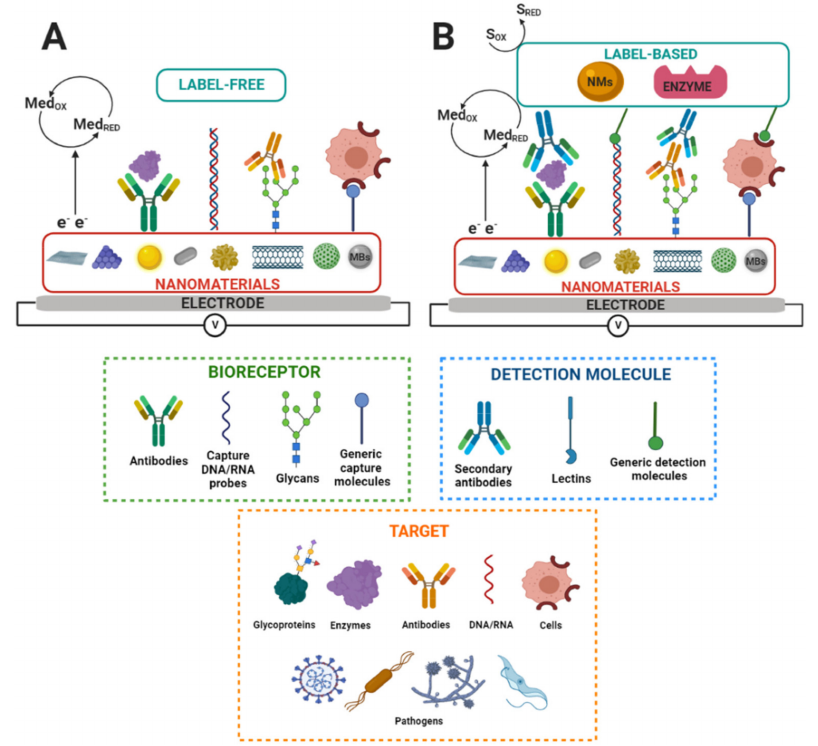
Figure 2. Scheme of nanostructured electrochemical biosensors. S RED and S OX and Med RED and Med OX indicate substrate reduction and oxidation and mediator reduction and oxidation,